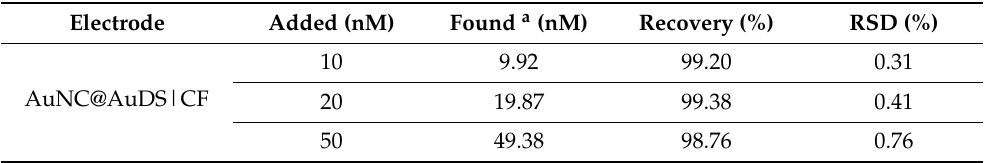
Table 2. Real sample analysis studied on the basis of recovery tests of NO 2 − for the AuNC@AuDS|CF microelectrode for real human serum sample (n =